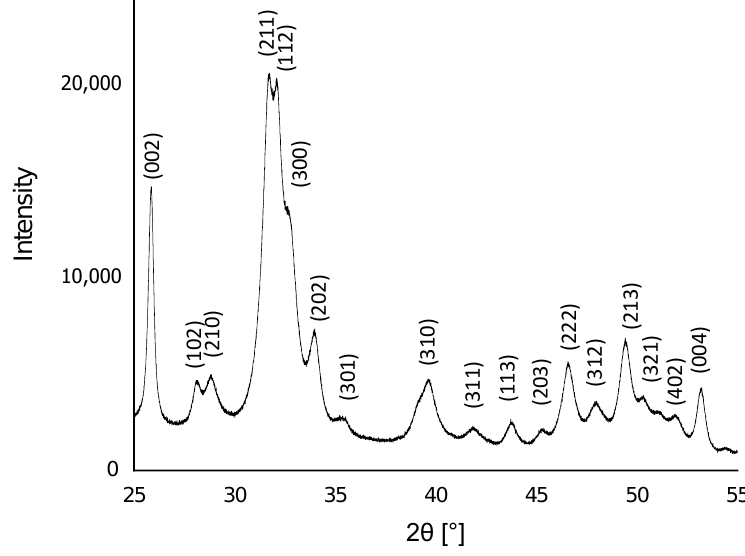
Figure 1. XRD spectrum of HA obtained by wet precipitation method.